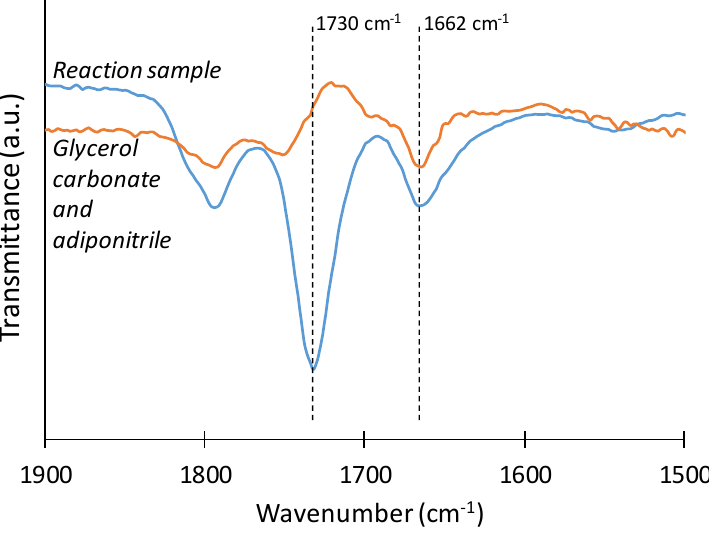
Figure 6. ATR-FTIR spectra from 1900–1500 cm −1 of the liquid-phase resulting from: the reaction of glycerol, CO 2 and adiponitrile; and the reaction of glycerol carbonate, CO 2 and adiponitrile. Reaction conditions: Reaction pressure = 45 bar, 6 wt.% C-La 2 O 3 to glycerol ratio, 22.5 mmol glycerol, 45 mmol adiponitrile, 18 h and reaction temperature = 160 °C.